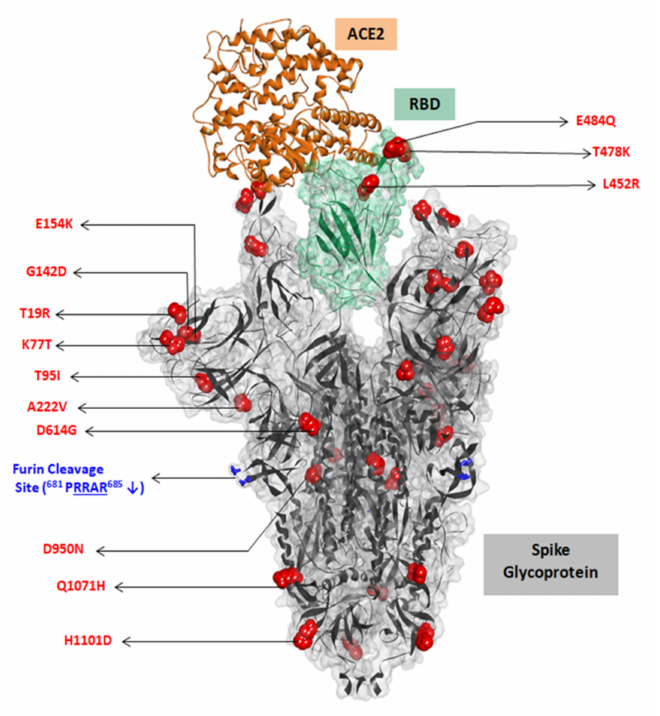
Figure 4. Mapping of key mutations on the furin-cleaved crystal structure of SARS-CoV-2 spike glycoprotein (gray surface view) in complex with ACE2 (solid brown ribbon). RBD region shown in green.